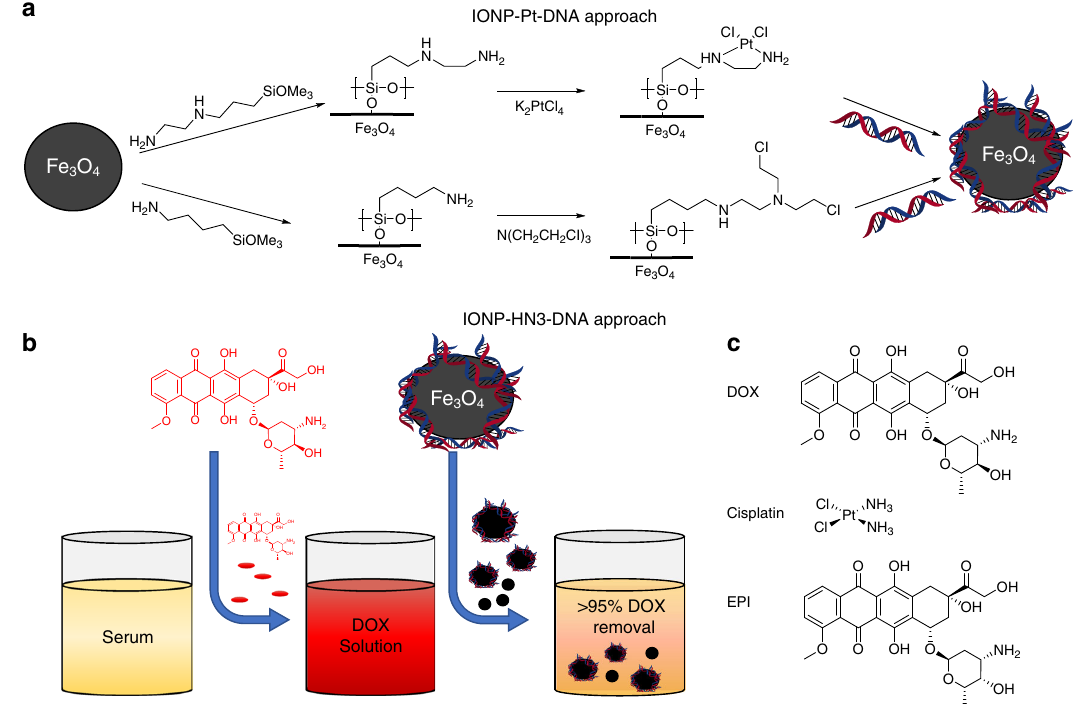
Fig. 1 Experimental approach. a Two synthetic approaches for covalently attaching genomic DNA onto iron-oxide nanoparticle ( IONP ) surfaces. b Drug capture concept. c Three common chemotherapy agents used in this